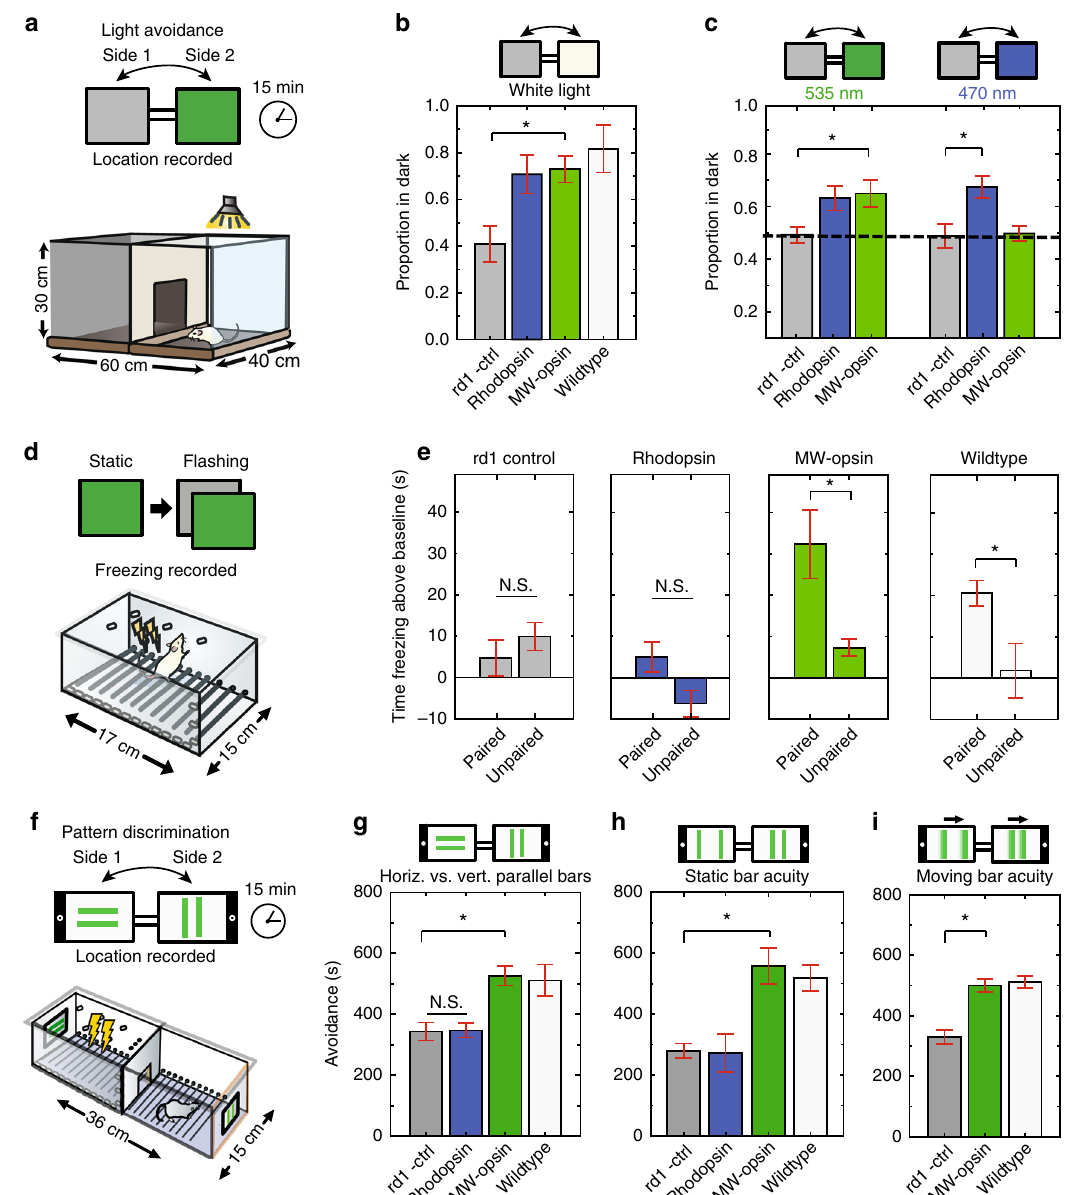
Fig. 3 Light avoidance and learned visually guided behavior in rd1 mice expressing MW-opsin or rhodopsin in RGCs. a Schematic of light/dark box for light avoidance test. b , c Respectively for b , c -left and c -right, proportion of time spent in the dark compartment (proportion of avoidance) for rd1 control (gray; n = 5,8,5 mice), rd1 expressing rhodopsin in RGCs (blue; n = 6,8,5 mice) or MW-opsin (green; n = 11,10,4), and wt mice (white; n = 5 mice) when illuminated with either ( b ) white light (100 μ W cm − 2 ), ( c ) 1 μ W cm − 2 blue light (470 nm) (right) or green light (535 nm) (left). d Schematic of